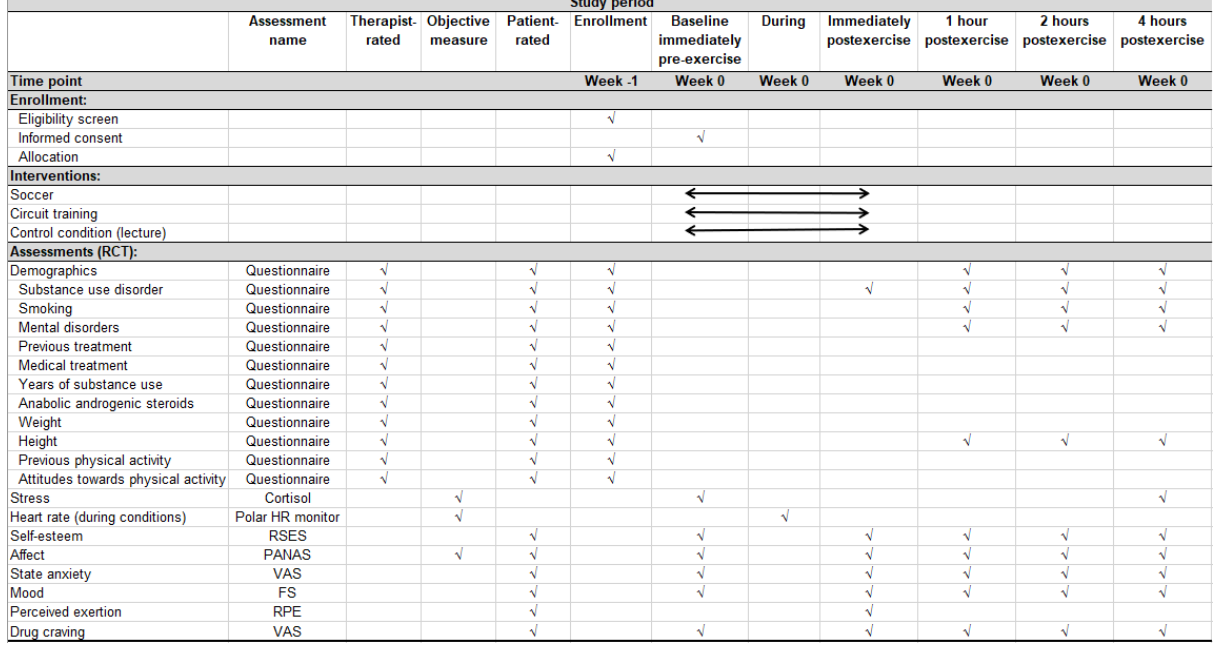
Figure 2. SPIRIT figure, study measures, and assessment time points. FS: Feeling Scale; HR: heart rate; PANAS: Positive and Negative Affect Schedule; RCT: randomized controlled trial; RPE: Rating of Perceived Exertion; RSES: Rosenberg Self-Esteem Scale; VAS: visual analog